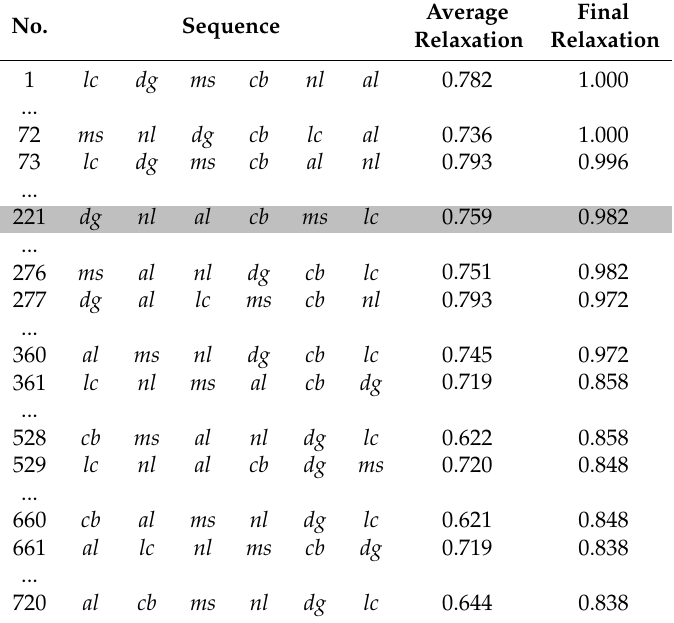
Table 6. Effect of different adaptation sequences on the final and average relaxation for indoor environments. The list is ordered according to decreasing final and average relaxation. The highlighted sequence is the order used in the heuristic